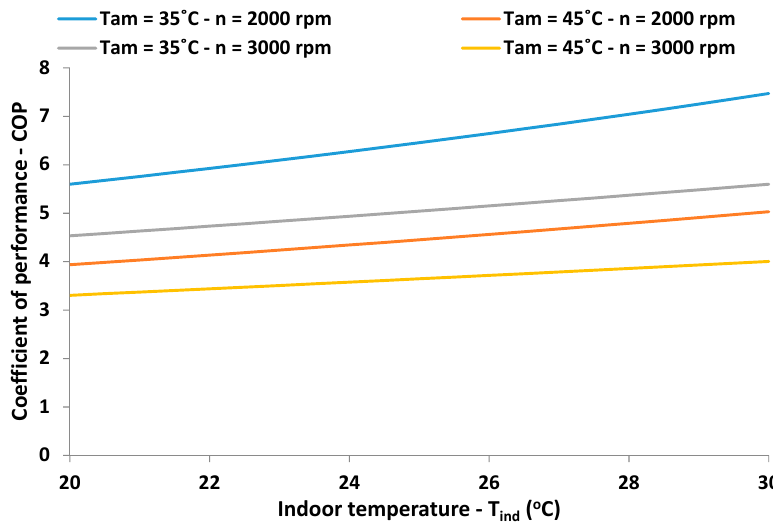
Figure 10. Coefficient of performance for different indoor temperatures.